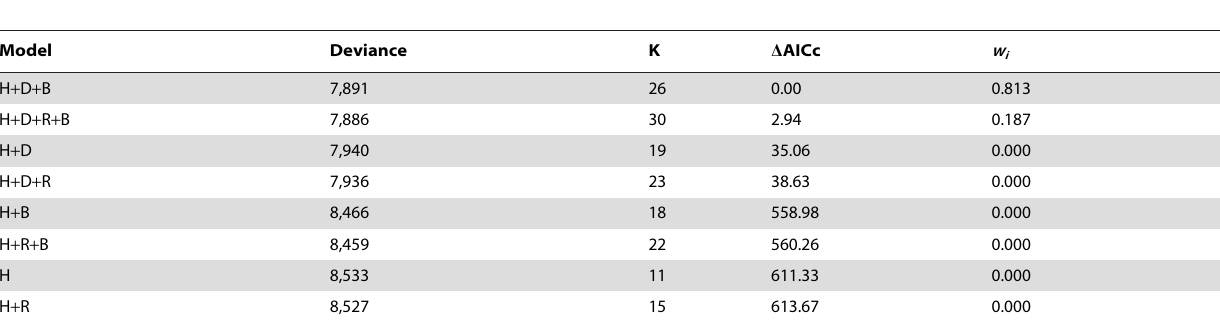
Table 2. Summary of a priori models based on resource selection functions that predict the probability that a breeding Ring-billed gull will forage in a patch (200-m radius) for a 100-s residence time threshold.